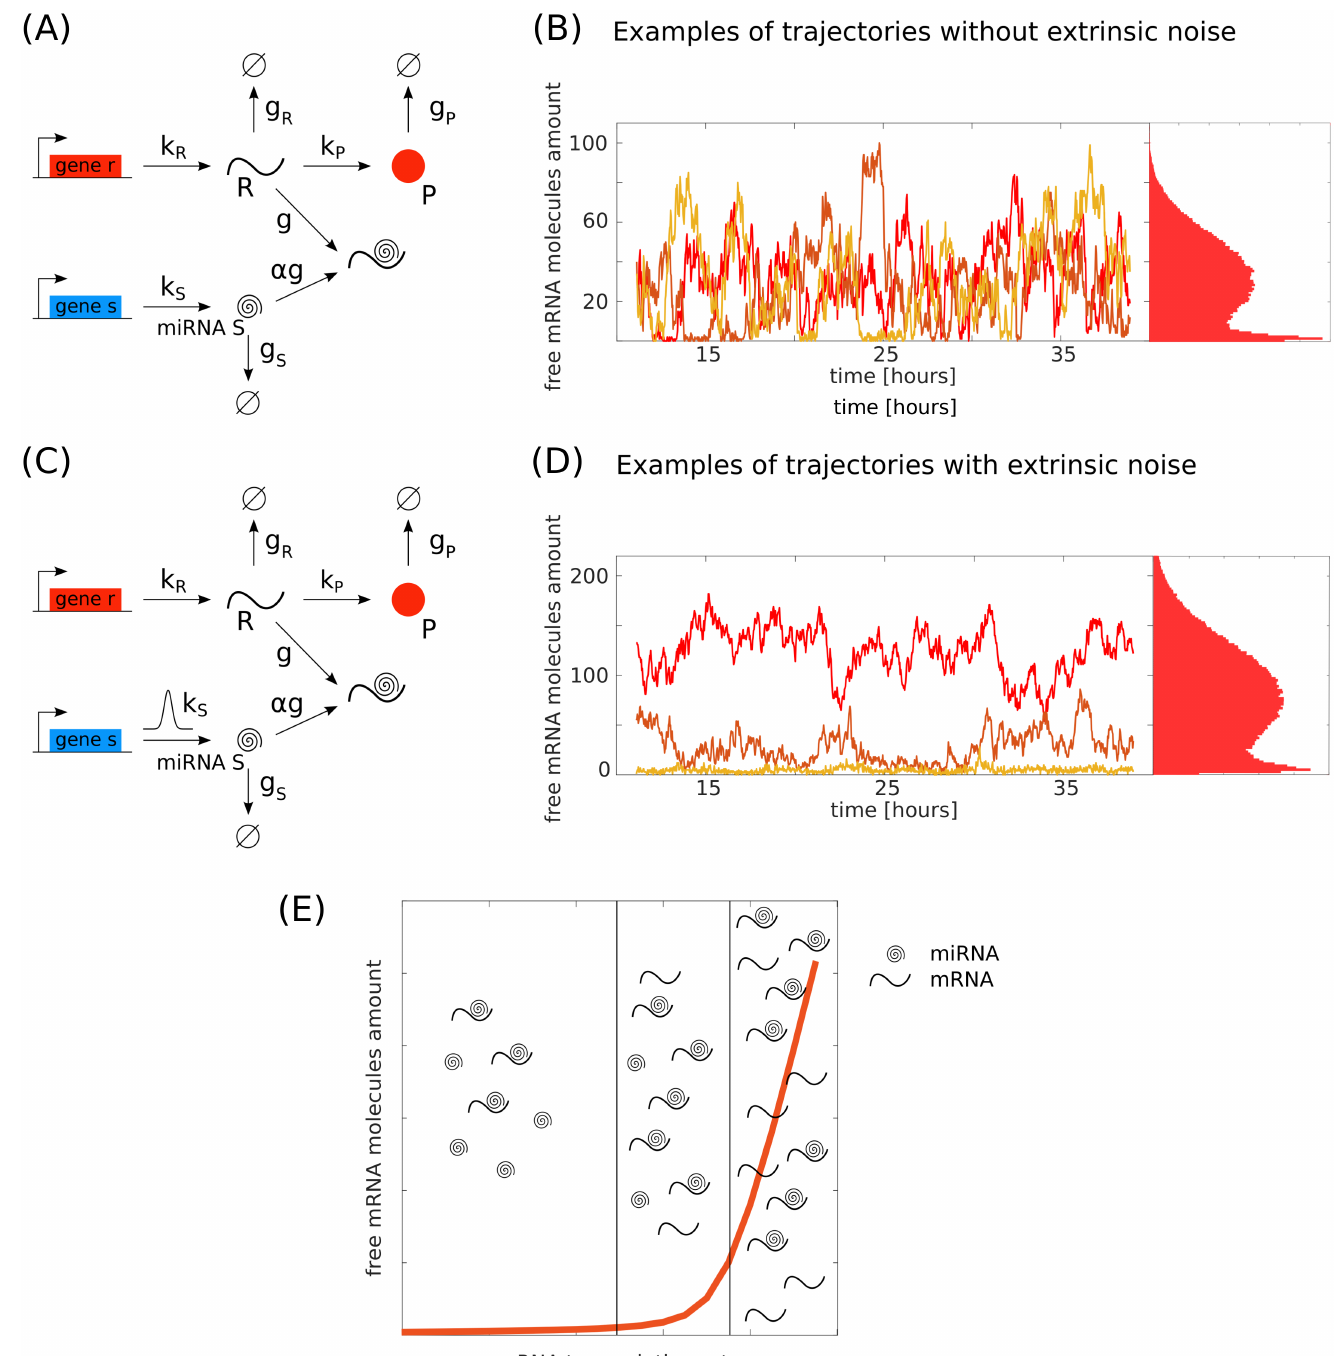
Fig 1. Model and steady-state trajectories. The reference circuits (with and without extrinsic noise on the miRNA transcription rate) are represented in (C) and (A) respectively with the rates considered in the model. k R and k S are the target mRNA and miRNA transcription rates, g R and g S are respectively the mRNA and miRNA degradation rates. k is the protein translation rate and g is its degradation rate. g is the miRNA-target interaction strength and α is the fraction of miRNAs that are P P not recycled after binding to the mRNA. In panels (B) and (D) there are three different trajectories for the mRNA, corresponding to the model on the left. For both panels, the steady-state distributions of the number of free mRNA molecules are bimodal. In (B) the parameters are k S = 1.2 × 10 −3 nM min −1 , k R = 2.7 × 10 −3 nM min − 1 , g = 1.2 × 10 − 2 min − 1 , g = 2.4 × 10 − 2 min − 1 , g = 1.5 × 10 3 nM − 1 min − 1 , k = 6.0 min − 1 , g = 1.2 × 10 − 2 min − 1 and α = 0.5. In (D) the parameters are k S R P P 3.1 × 10 −3 nM min −1 , g S = 1.2 × 10 −2 min −1 , g R = 2.4 × 10 −2 min −1 , g = 1.2 × 10 2 nM −1 min −1 , k P = 6.0 min −1 , g P = 1.2 × 10 −2 min −1 and α = 0.5. k S are picked from a Gaussian distribution with mean k ¼ 1 : 2 (cid:2) 10 (cid:0) 3 nM min (cid:0) 1 and standard deviation σ = 2.4 × 10 −4 nM min −1 . (E) Cartoon of the free mRNA threshold behaviour as S